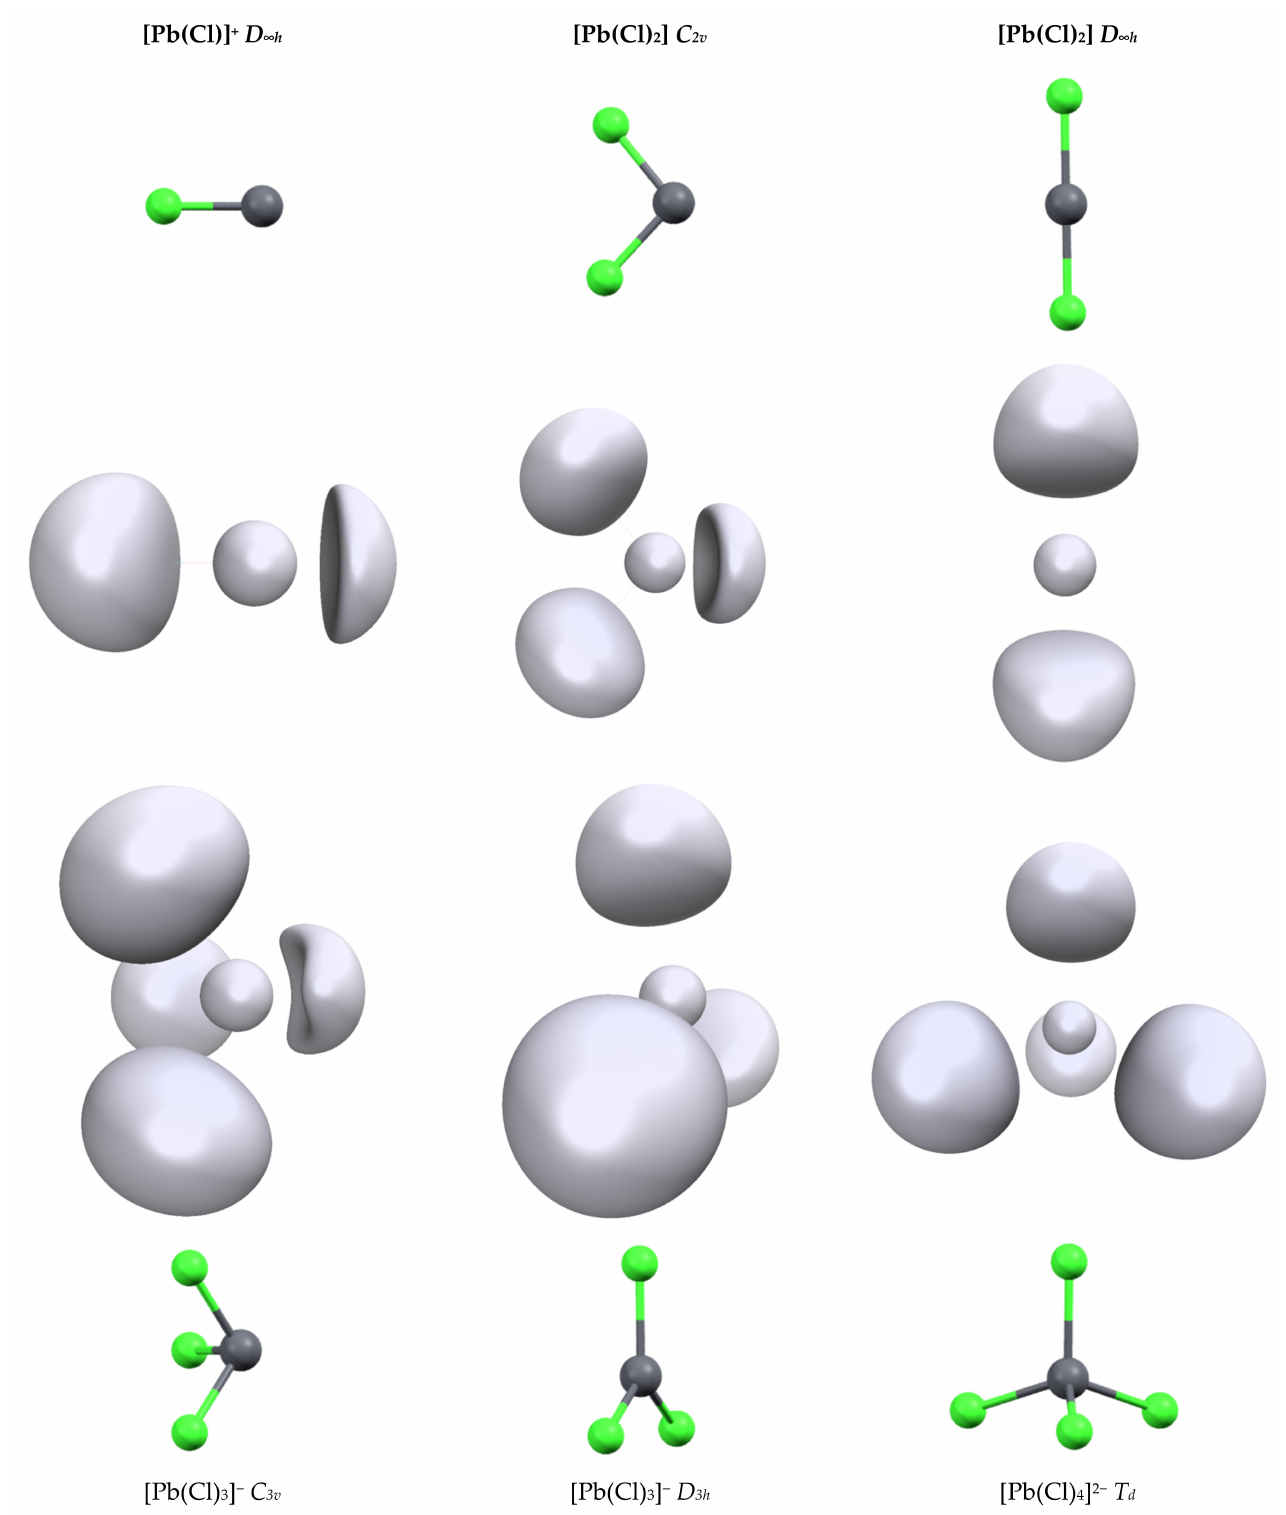
Figure 1. Structures and ELF function ( η = 0.65) of the different [Pb(Cl) n ] q